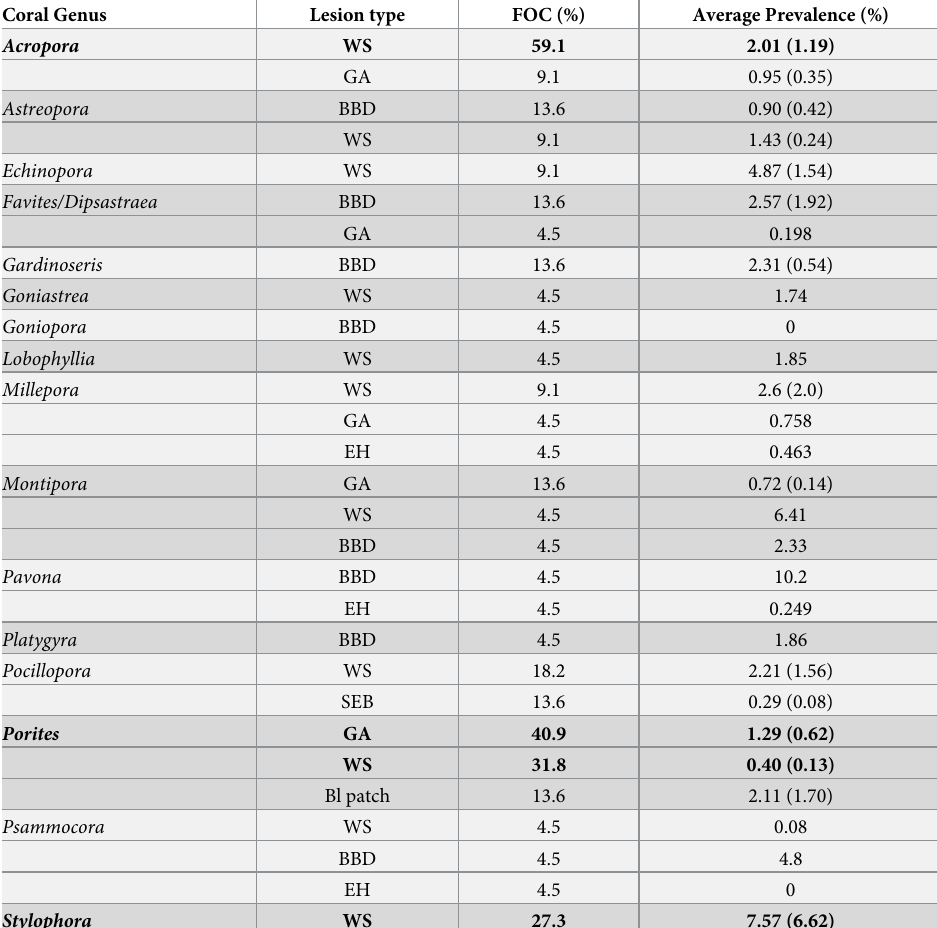
Table 2. Frequency of occurrence (FOC) and average prevalence of coral diseases recorded during surveys. Coral Genus